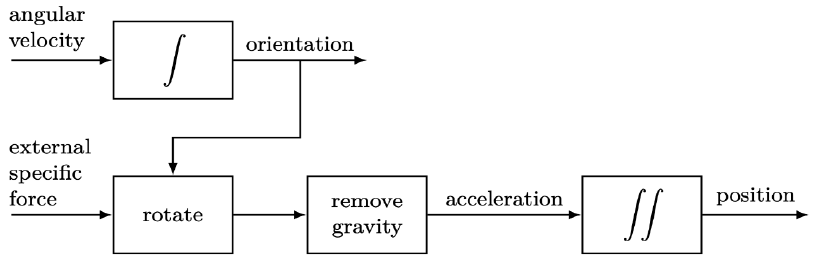
Figure 4. Schematic illustration of dead reckoning, where the accelerometer measurements (external specific force) and the gyroscope measurements (angular velocity) are integrated into the position and orientation of a mobile phone [44].